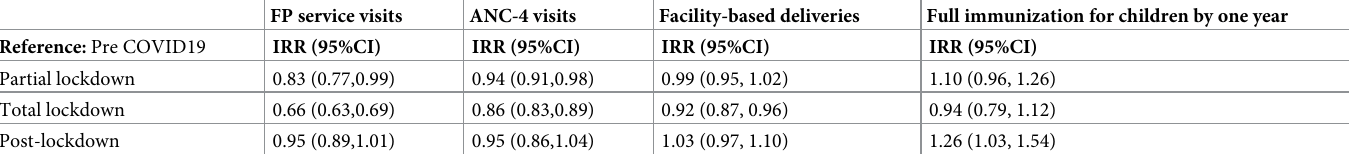
Table 1. Incidence rate ratios and percent change in key outcomes during 2020 study period, relative to the pre-COVID-19 period (January 2018—December 2019). FP service visits ANC-4 visits Facility-based deliveries Full immunization for children by one